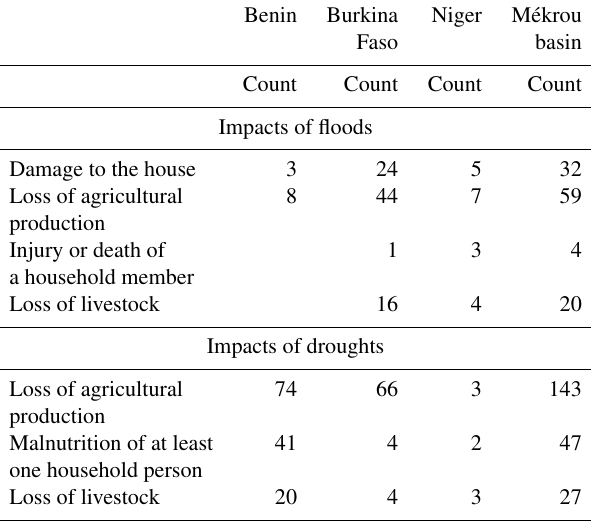
Table 8. Impacts of extreme floods and droughts to the households.